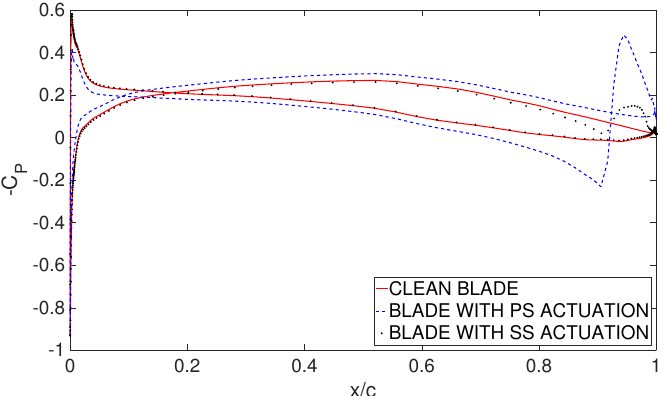
Figure 9. Pressure coefficient distribution on the clean blade and with PS/SS actuation; Re ∼ 350,000; α = 2